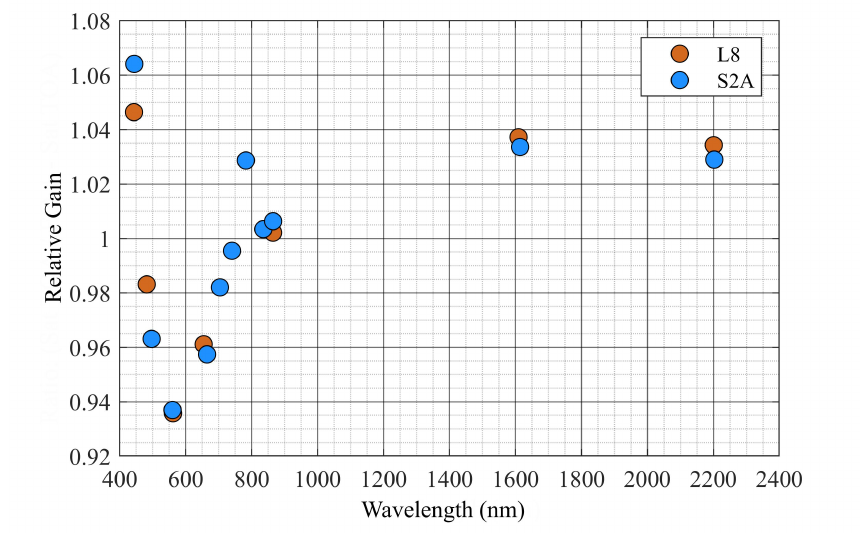
Figure 10. Relative gain for L8 and S2A vs. the central wavelength.